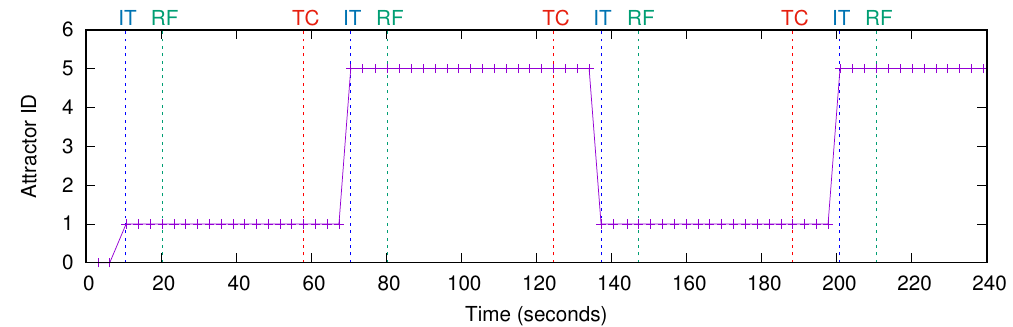
Figure 10. The identified traffic pattern by the decision